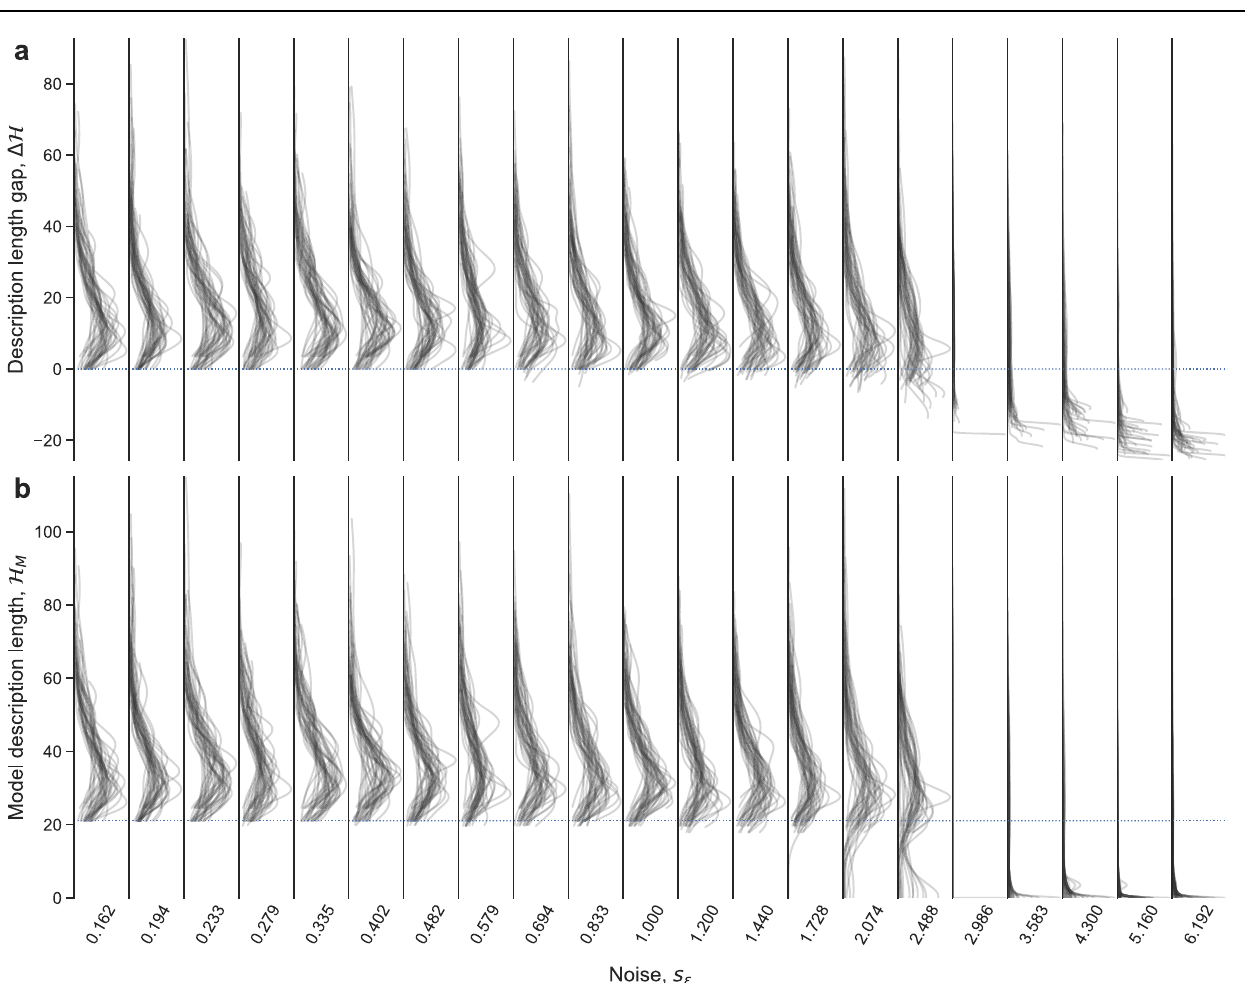
less plausible than the true generating model m * , and vice versa. When there is a model m withnegativegapforagivendataset D ,thetruemodelisunlearnablefrom that dataset because m * is not the most plausible model given the